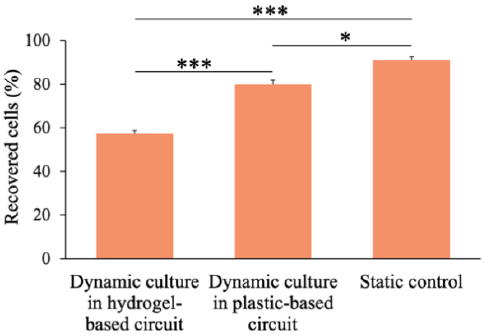
Figure 7. Number of recovered cells from the hydrogel-based circuit, the plastic tube-based one and the static control after 24 h. Values are reported as mean ± s.d., N = 3, student’s t-test: * p < 0.05, *** p < 0.001.